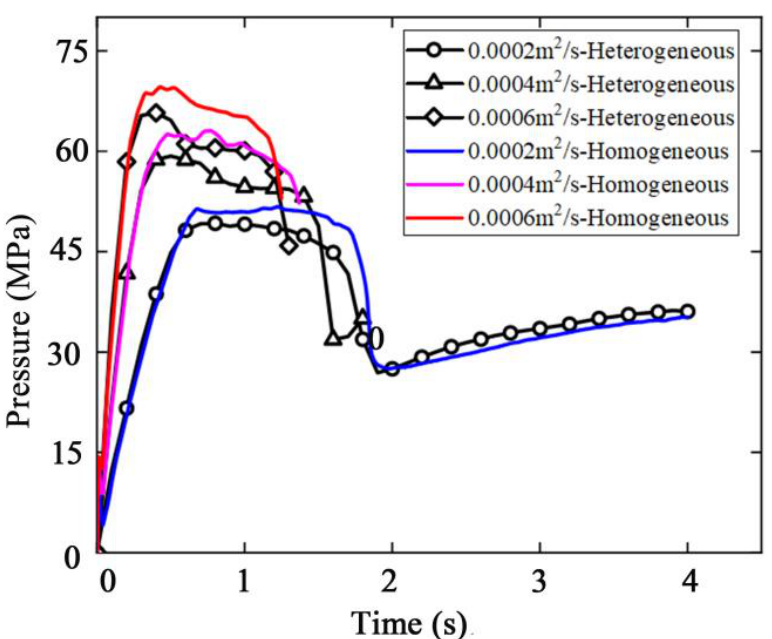
Figure 6. Pressure curves at injection point under different injection rates in heterogeneous and homogeneous reservoir.